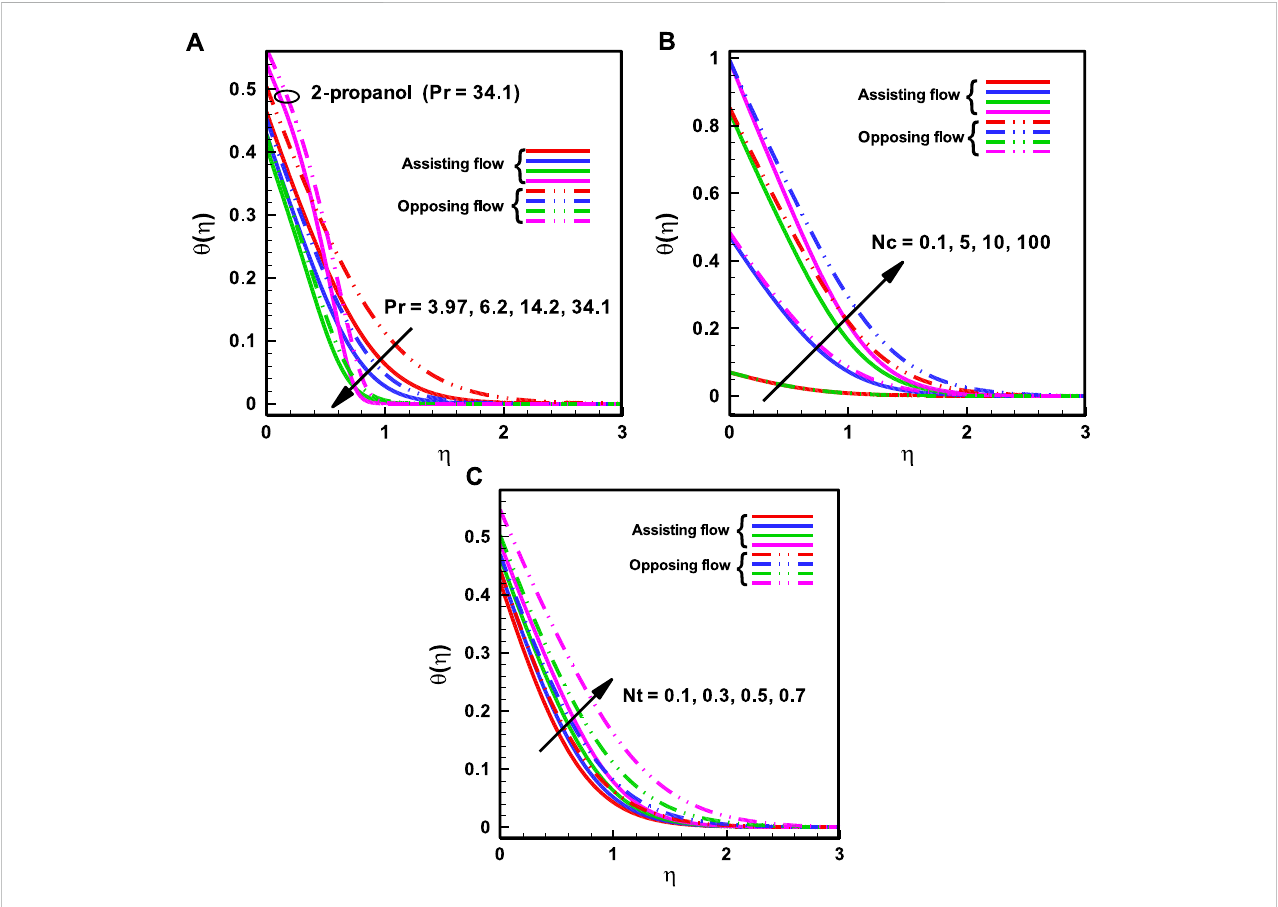
FIGURE 3 Variation of Temperature Pro fi le for (A) P r , (B) The ratio of buoyancy forces on the rescaled nanoparticle volume fraction N c (C) The thermophoresis parameter N t .